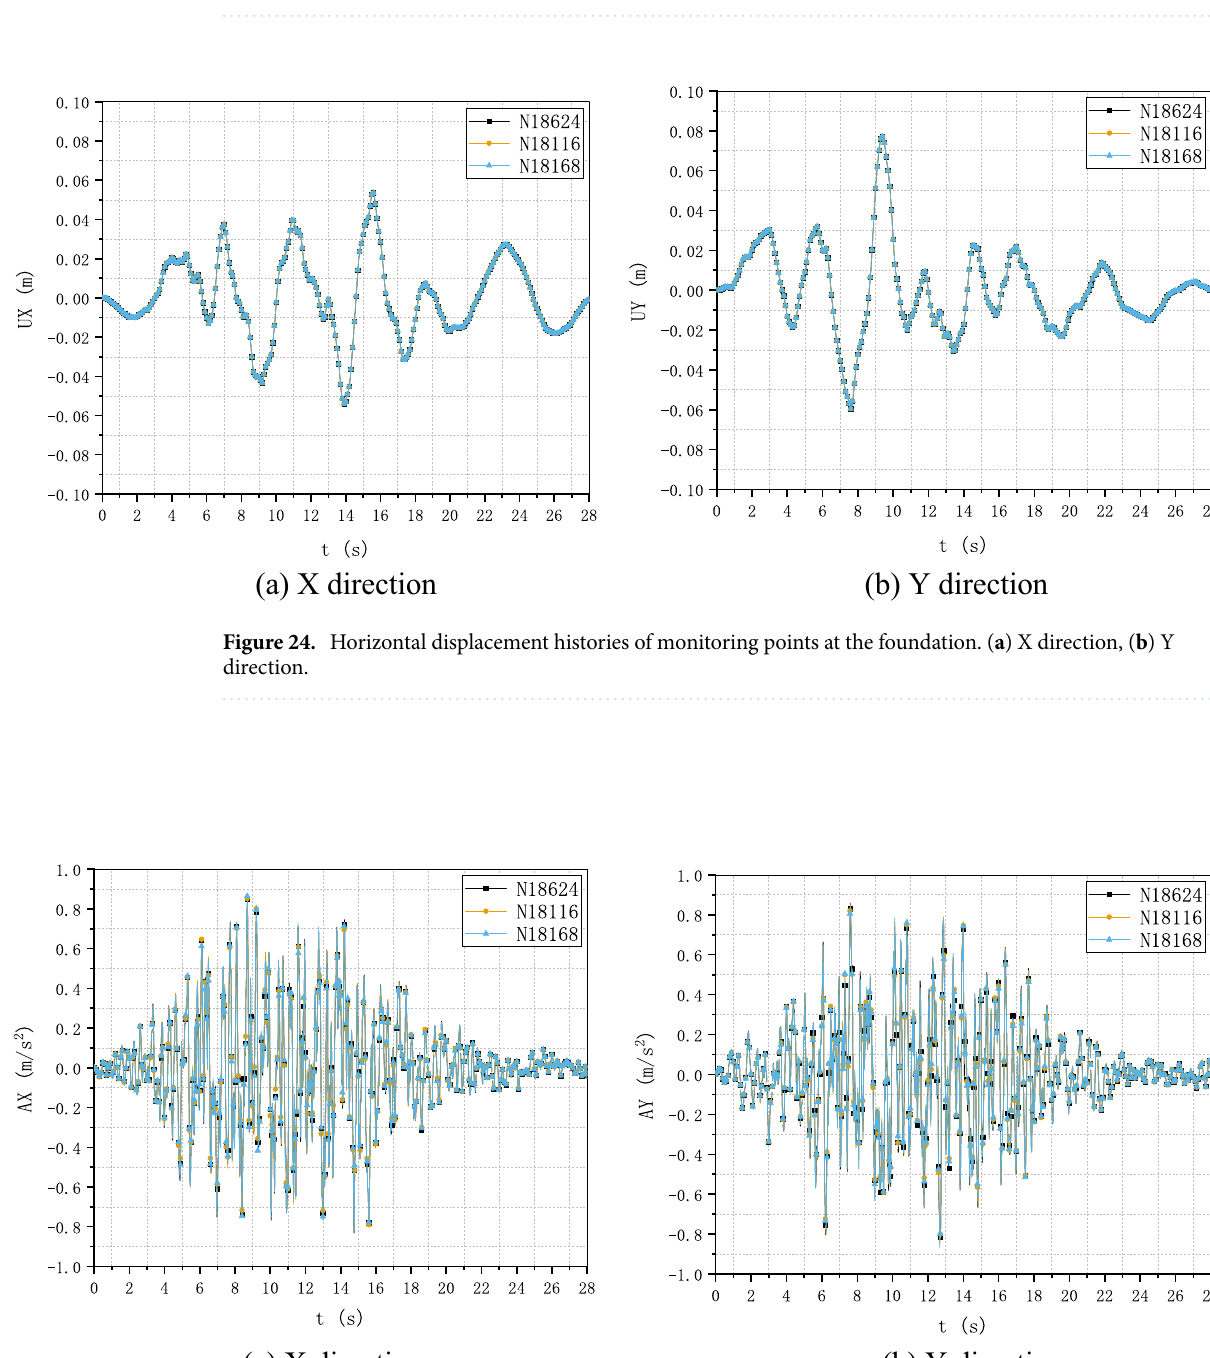
Table 6. Locations of monitoring points of the nuclear power plant.